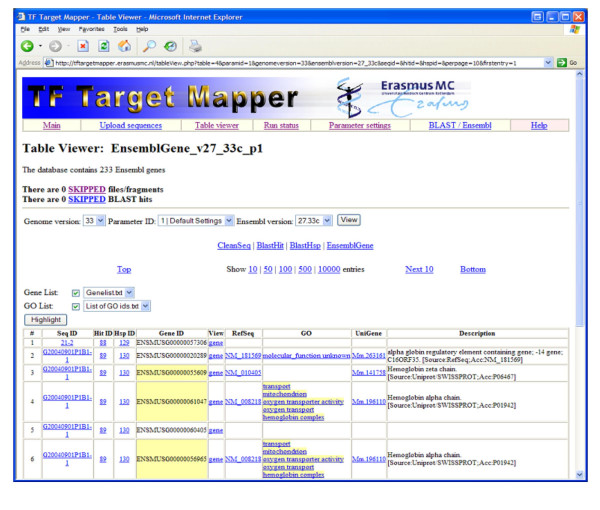
Gene list output containing known targets of the transcription factor GATA-1 :  Example of a gene list output containing known targets of the transcription factor GATA-1 (α and ζ globin, highlighted in yellow). Information and links on the submitted sequences (seq ID), hit ID, HSP ID, Gene ID, contig/gene view, RefSeq, GO terms, Unigene information and description are depicted (HSP: High-scoring Segment Pair, fundamental unit of BLAST algorithm output representing local alignments with no gaps that achieve one of the top alignment scores in a given search, hit: general term containing one or more HSPs separated by gaps located in proximity in the sequence, GO: Gene Ontology).